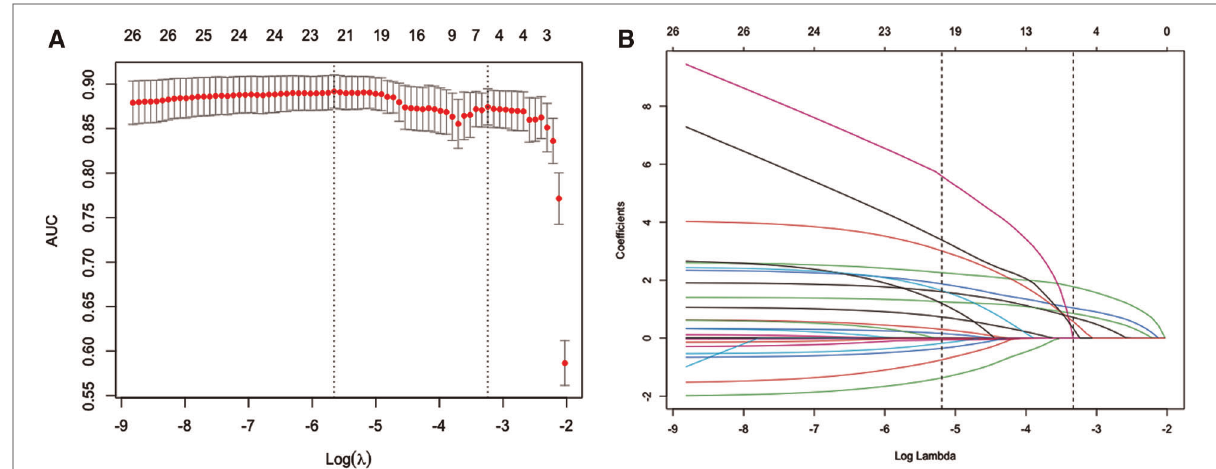
FIGURE 2 Possible risk factors for apnea using the LASSO binary logistic regression model and selection for using the least absolute shrinkage. ( A ) Optimal parameter ( λ ) selection in the LASSO model used 10-fold cross-validation via minimum criteria. The predicted AUC from the LASSO regression cross-validation procedure was plotted as a function of log ( λ ). The x -axis and y -axis represent the log ( λ ) and predicted AUC, respectively. The red dots represent the average predicted AUC for each model with a given λ . Vertical lines were drawn at the optimal values by using the minimum criteria and the 1 standard error (SE) of the minimum criteria (the 1-SE criteria). A λ value of 0.039 with log ( λ )= − 3.237 was chosen (1- SE criteria). ( B ) LASSO coef fi cient pro fi les of the 26 features. A coef fi cient pro fi le plot was produced against the log ( λ ) sequence. Vertical line was drawn at the value selected using 10-fold cross-validation, where the 6 resulting features (1-SE criteria) with nonzero coef fi cients are indicated in the plot.